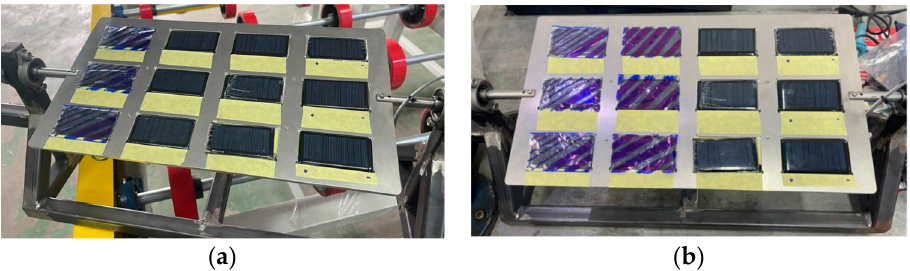
Figure 4. ( a ) Case 1: single string; and ( b ) Case 2: two strings are covered with translucent sheets.